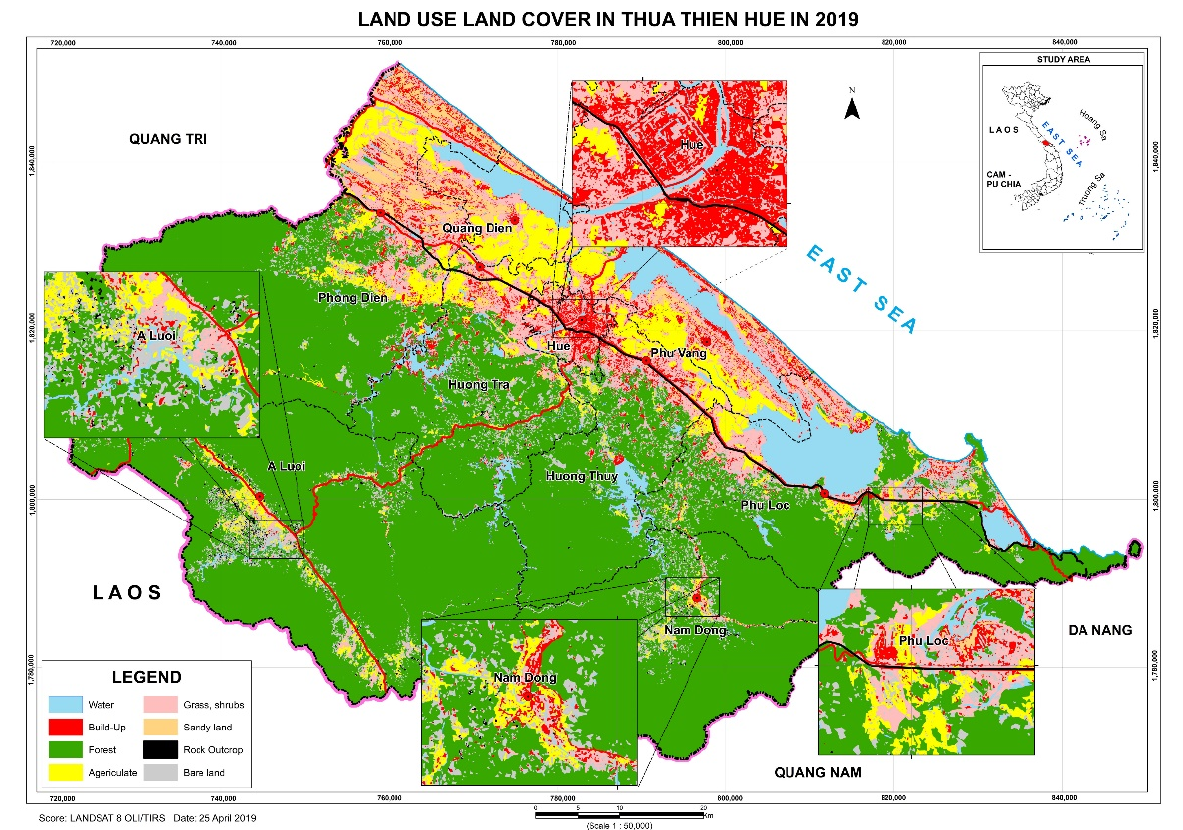
Figure 3. Segmentation levels of Landsat 8 OLI.